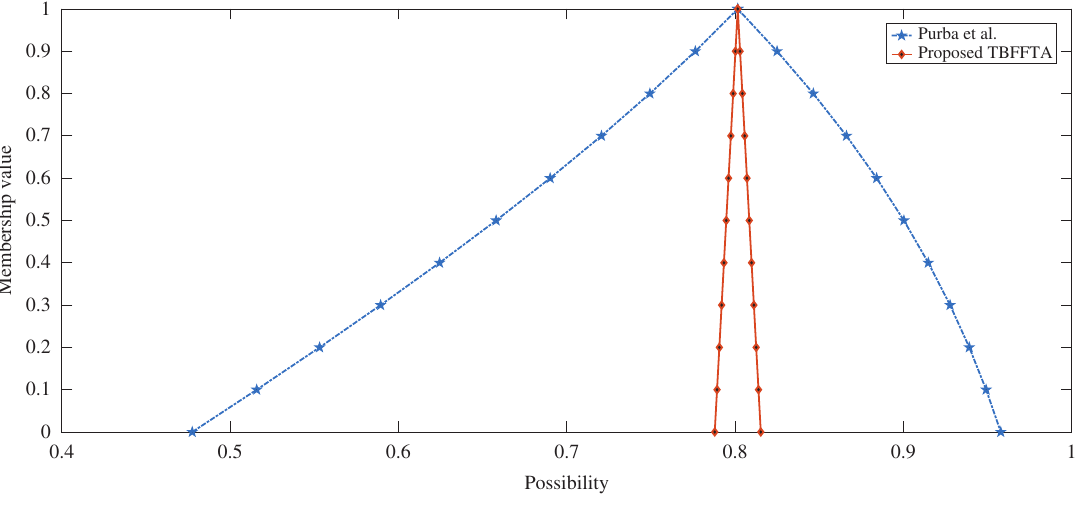
Figure 4: The Upper Bound Fuzzy Possibility of the Top Event. Table 10: The Best Estimate, Lower Bound, and Upper Bound Fuzzy Possibilities of Top Event CERPS Group 1 Fault Computed by Different